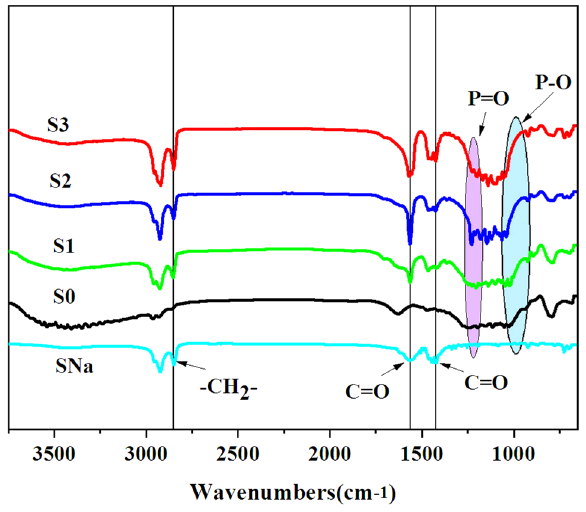
Figure 1: FT - IR spectrum of di ff erent samples.